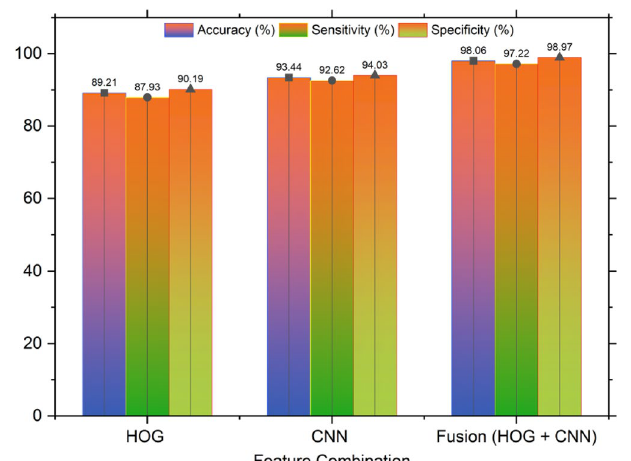
Figure 9. Performance comparison of a fused feature vector.